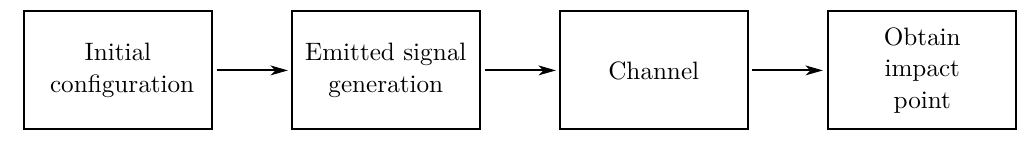
Figure 10. General diagram of the simulator.